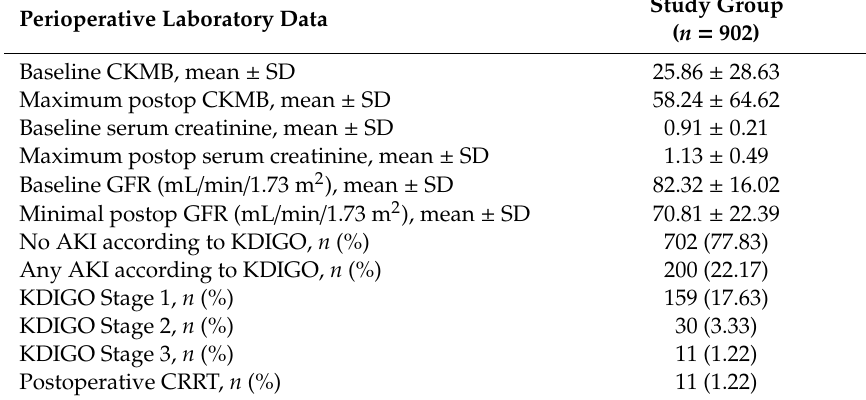
Table 2. Perioperative laboratory data and Kidney Disease Improving Global Outcome (KDIGO)